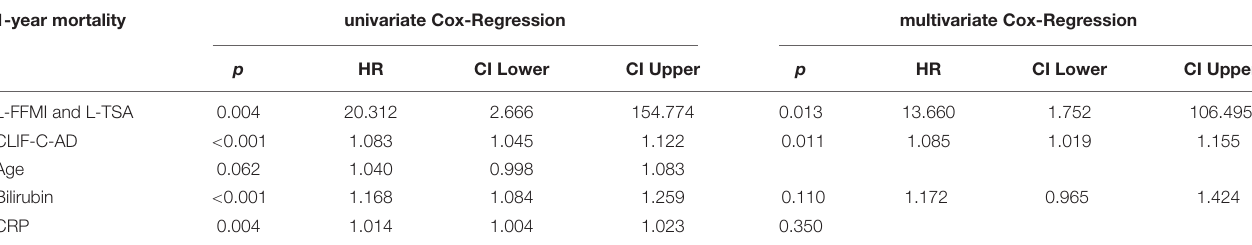
TABLE 5 | Univariate/multivariate Cox-Regression for 1-year mortality comparing L-FFMI and L-TSA classification with H-FFMI and S-TSA classification. 1-year mortality univariate Cox-Regression multivariate